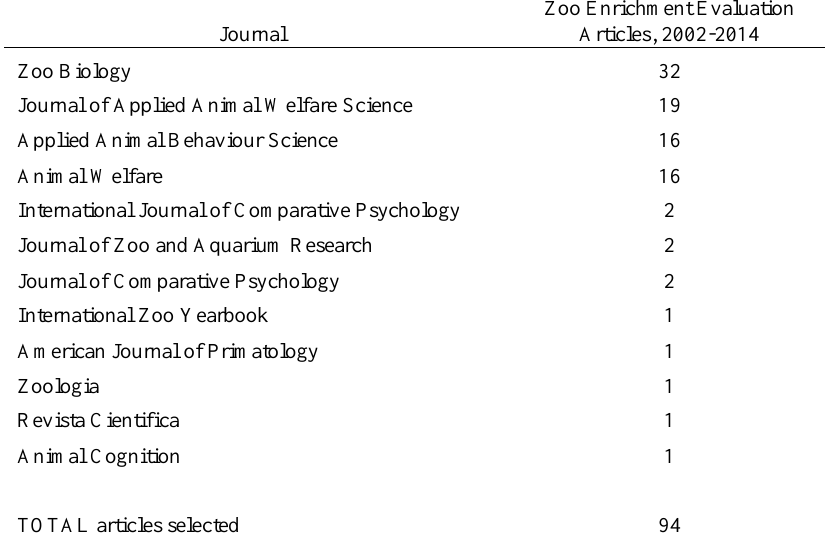
Number of Selected Zoo Enrichment Evaluation Articles per Journal, 2002-2014